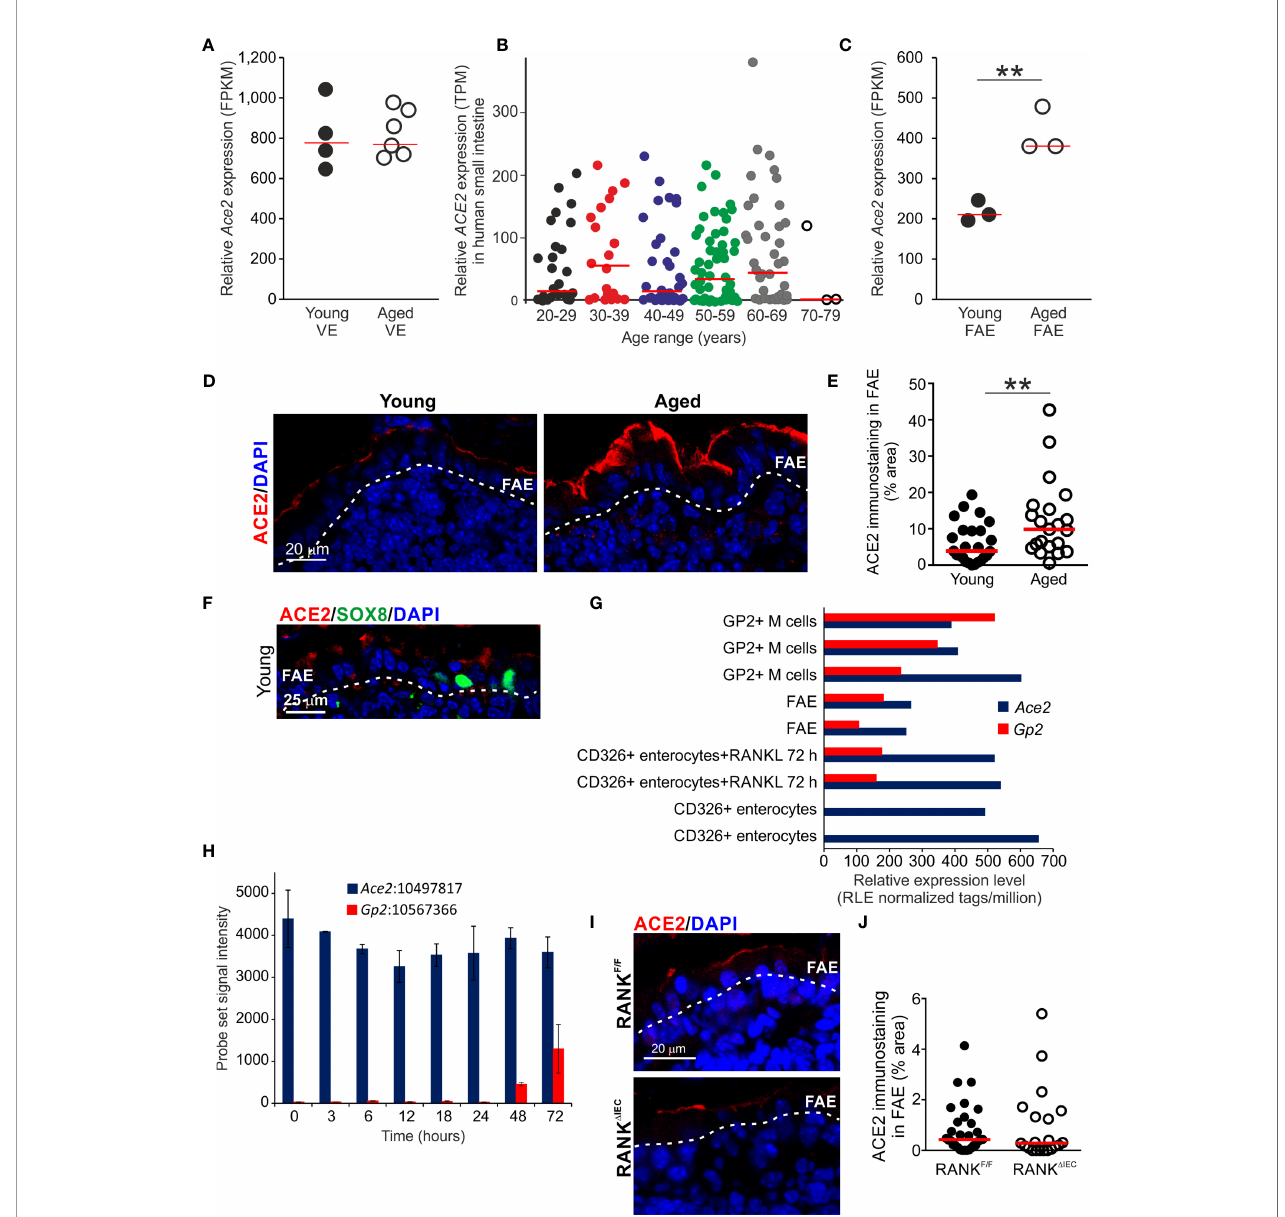
FIGURE 6 | Increased ACE2 expression in the aged FAE. (A) Equivalent levels of Ace2 mRNA expression (FPKM) in the VE of young and aged mice. Each point represents an individual mRNA data set. N=4-6/group. Horizontal bar, median. (B) Aging does not affect ACE2 mRNA expression in the human small intestine. Relative level of ACE2 expression (TPM) in a large collection of mRNA-seq data sets from human small intestine in the GTEx project (www.gtexportal.org). Each point represents an individual data set. Horizontal bars, median. (C) Increased expression of Ace2 in the FAE of aged mice. Each point represents an individual mRNA-seq data set. N=3/group. Horizontal bar, median. Statistical differences determined by t test. (D) |Increased abundance of ACE2+ immunostaining (red) in the FAE of aged mice. Sections counterstained with DAPI to detect cell nuclei, blue. Dotted line indicates the basal boundary of the FAE. (E) Analysis of the abundance of ACE+ immunostaining in the FAE of young and aged mice. N=21-24 FAE/group. Horizontal bar, median. Statistical differences determined by Mann-Whitney U test. (F) Immunostaining shows ACE2 (red) is expressed on cells throughout the FAE including SOX8+ M cells (green). Sections counterstained with DAPI to detect cell nuclei, blue. Dotted line indicates the basal boundary of the FAE. (G) Analysis of published deep CAGE sequence data sets (44) shows that Ace2 mRNA expression in enterocytes is not dependent on RANKL-stimulation. (H) Analysis of published mRNA microarray data sets (5) similarly shows that Ace2 mRNA expression in enterocytes is not dependent on RANKL-stimulation. ( I) IHC comparison of ACE2+ immunostaining (red) in the FAE of RANK D IEC mice (lower panel) and RANK F/F control mice (upper panel). Sections counterstained with DAPI to detect cell nuclei, blue. Dotted line indicates the basal boundary of the FAE. (J) Similar abundance of ACE+ immunostaining in the FAE of RANK D IEC mice and RANK F/F control mice. N=21-30 FAE/group. Horizontal bar, median. Statistical differences determined by Mann-Whitney U test, **P <